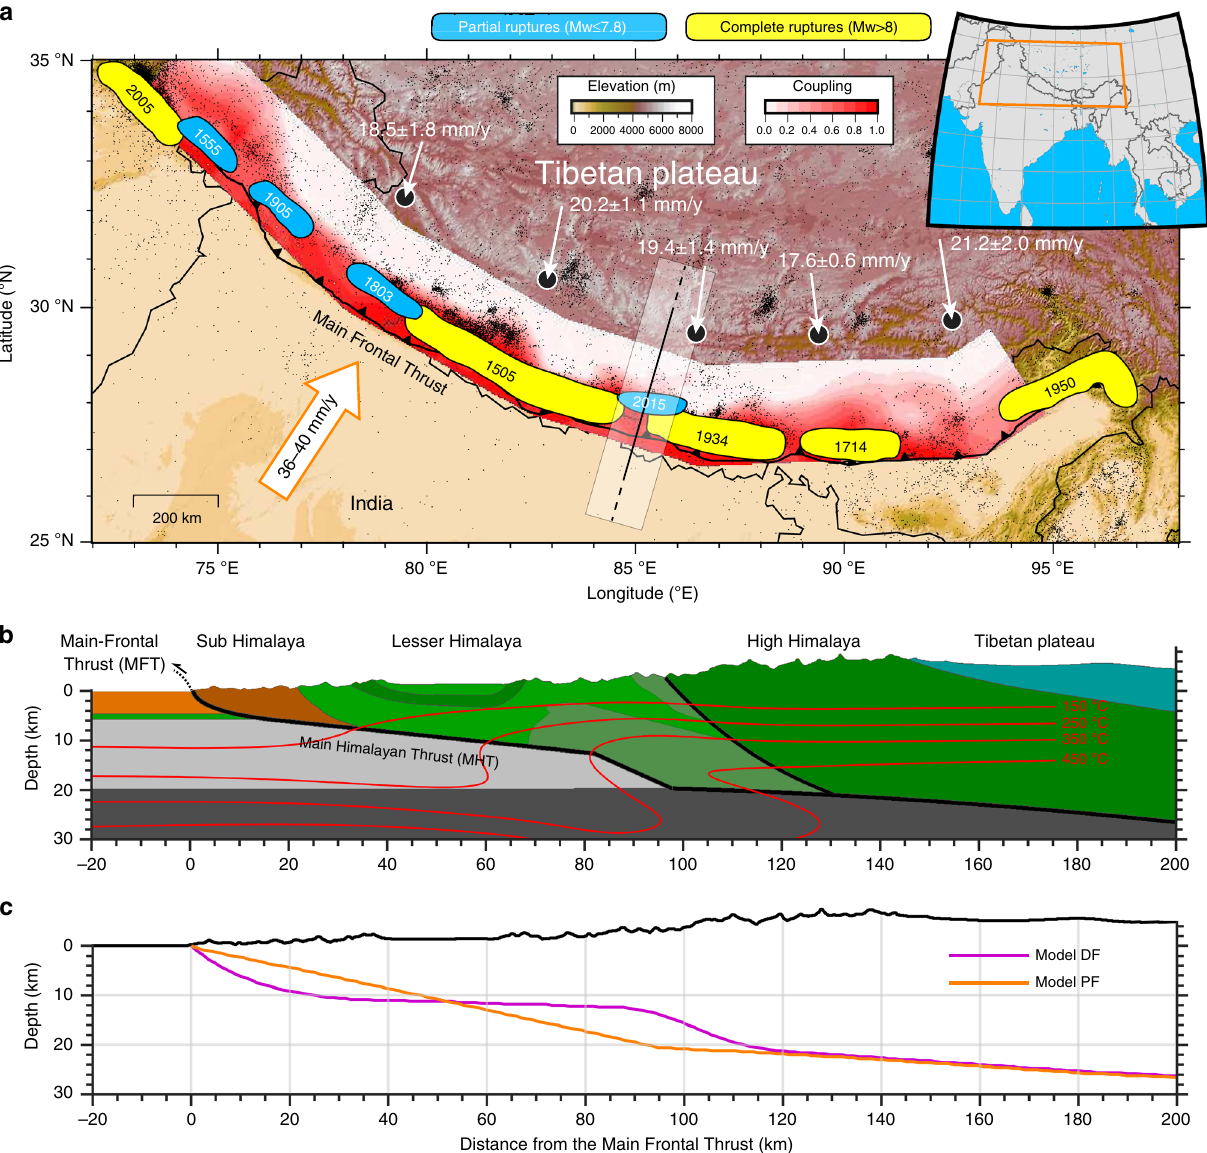
Fig. 1 Seismotectonic context, model setup and fault geometries. a , Topographic relief, coupling mode and historical seismicity. The white arrows show the long-term shortening across the arc. The interseismic coupling is shown as shades of red (ref. 48 ). A coupling value of 1 means the area is fully locked, while a value of 0 means fully creeping. Coloured patches indicate the supposed rupture zones since 1505 (refs. 4,21,22 ): blue patches display blind ruptures of large (Mw ≤ 7.8) earthquakes, whereas yellow patches indicate surface ruptures of great (Mw > 8) events. Black line indicates the cross-section utilised for the numerical model setup. b , Zoom of the initial reference setup (model EF) and temperature. The numerical setup represents the geological cross- section of the Nepal Himalaya constrained from the main-shock and aftershocks of the Gorkha sequence (ref. 9 ). c , Additional fault geometries employed in the numerical experiments: model DF, from Duputel et al. 10 , and a planar fault geometry (model